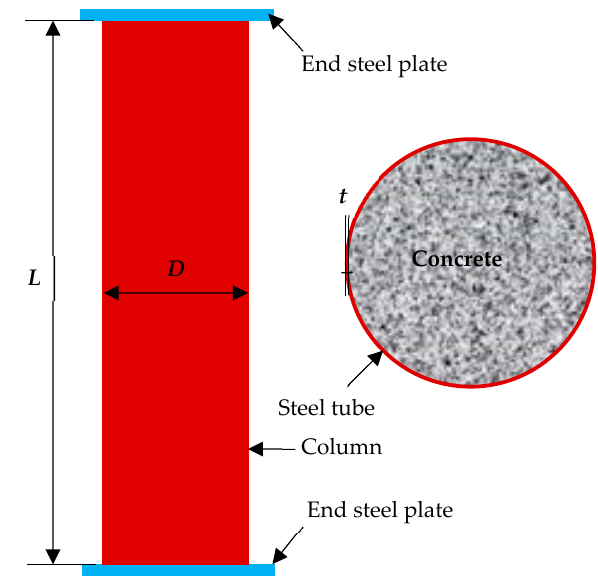
Figure 1. Schematic of a circular thin-walled CFST stub column .